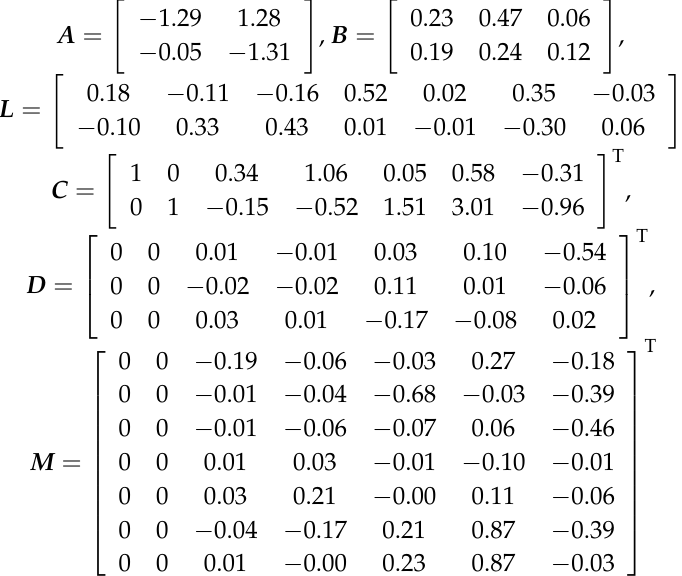
Figure 3. Health parameter estimation via SOSMO.